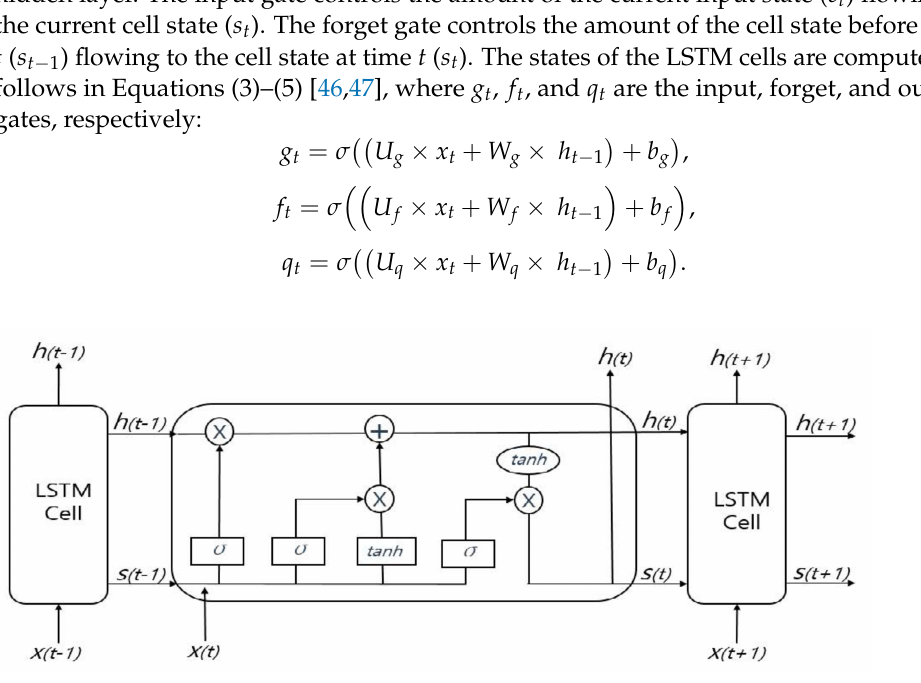
Figure 5. Structure of long short-term